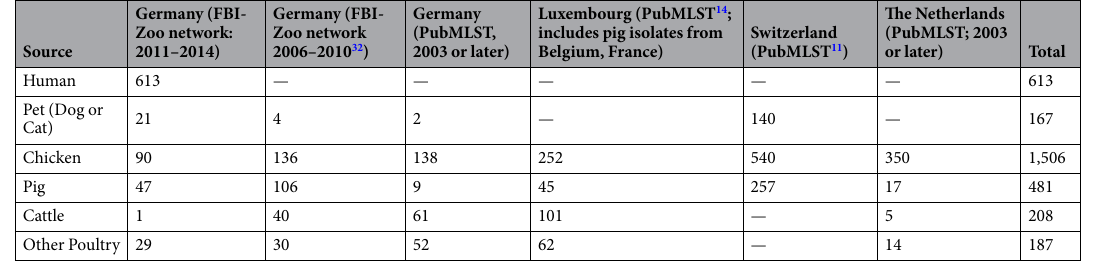
Table 1. Origin of Campylobacter isolates (typed with MLST) used for source attribution analysis. The source “other poultry” includes isolates from ducks (n = 47), turkeys (n = 102), geese (n = 11), and quails (n =